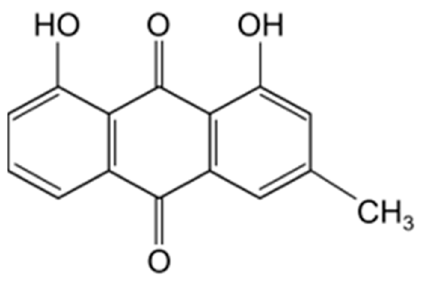
Figure 1. Chemical structure of chrysophanol.